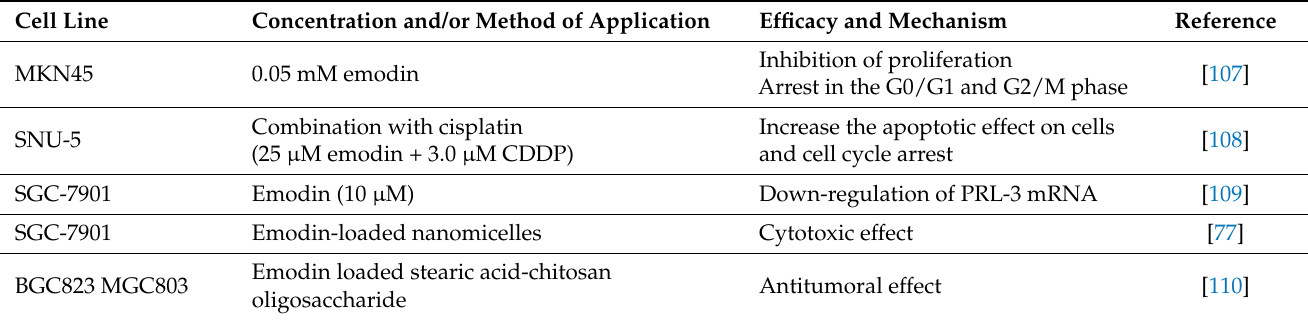
Table 3. Summary of in vitro biochemical effects of emodin in gastric cancer cell lines. Cell